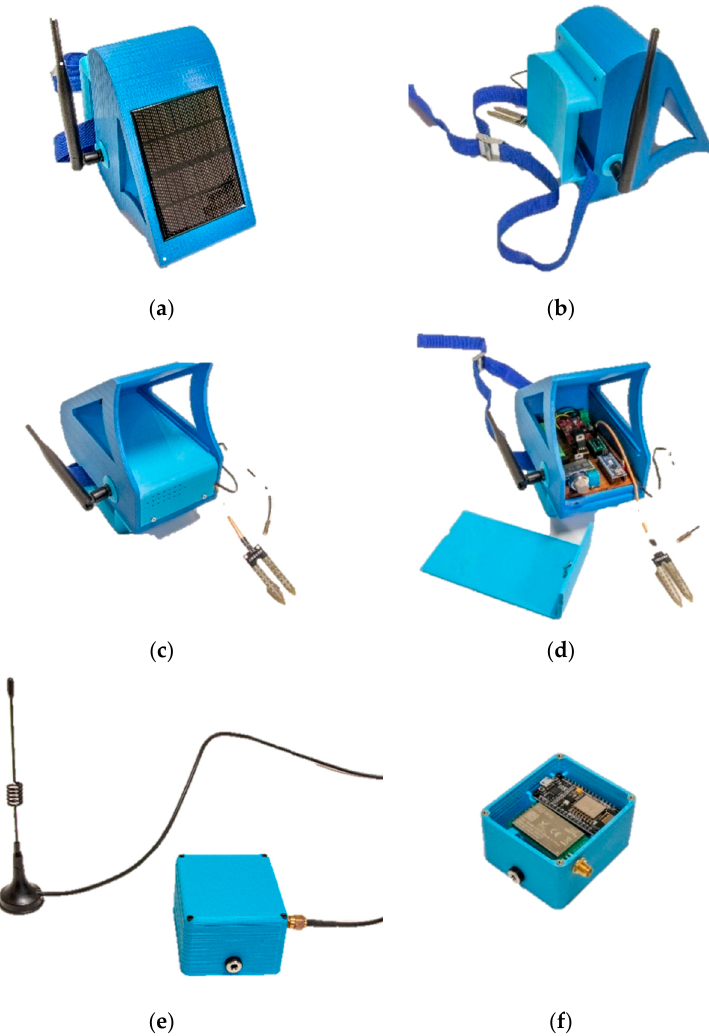
Figure 2. Prototype photos: ( a ) frontal view; ( b ) back view; ( c ) bottom view; ( d ) inner view; ( e ) central repeater overview; ( f ) central repeater inside view.